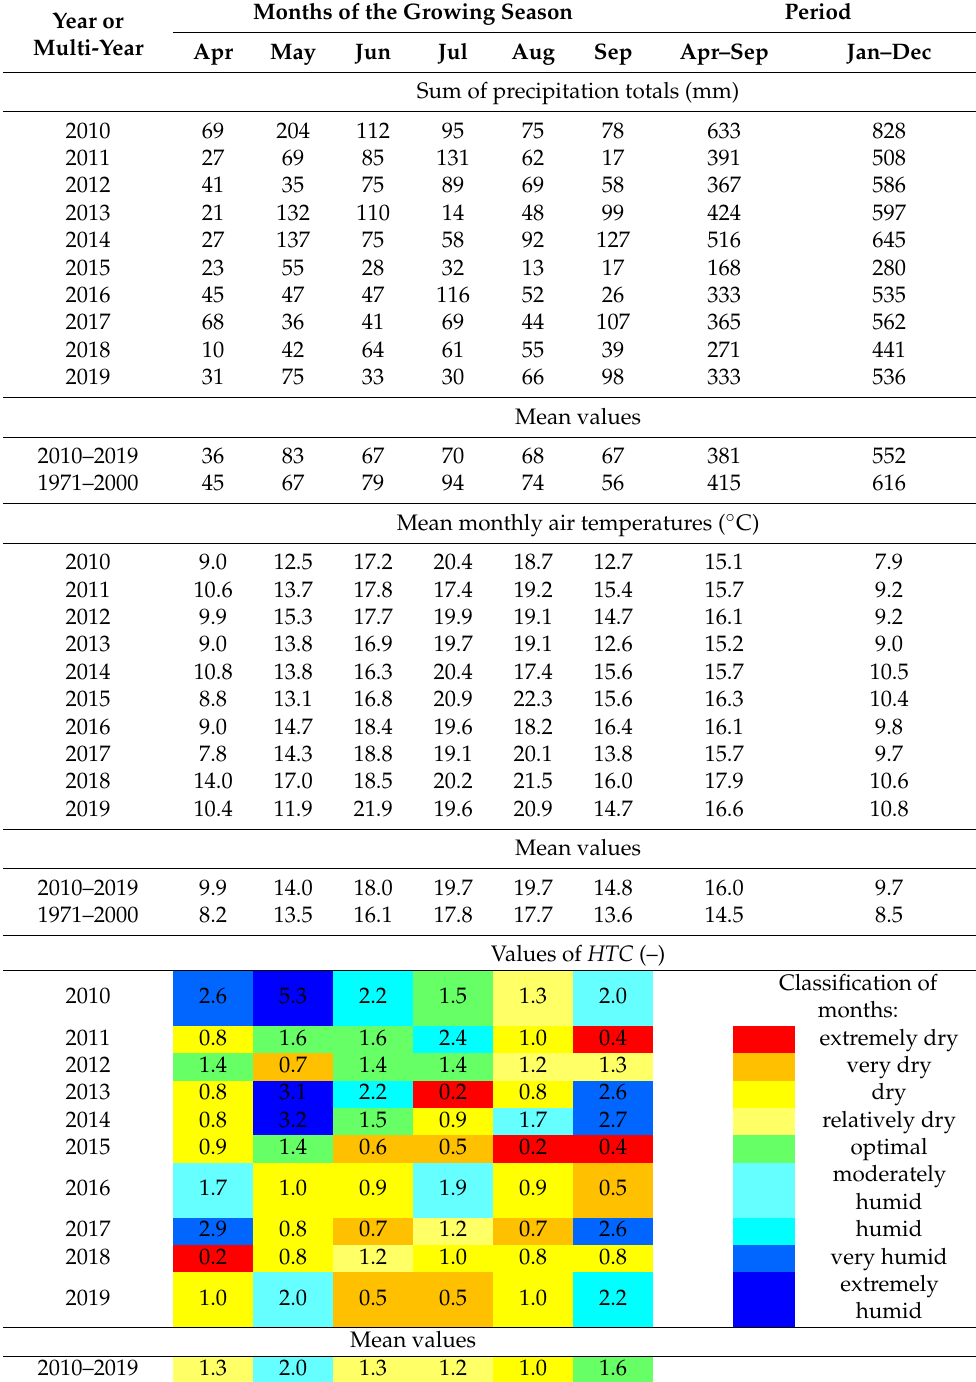
Table 1. The characteristics of meteorological conditions of the study